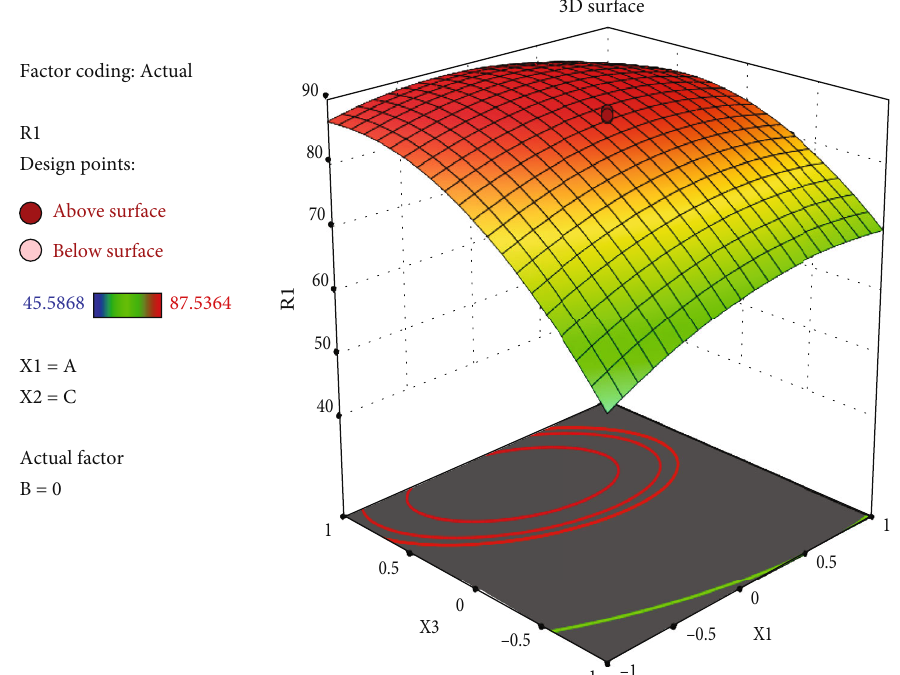
) and time ( X ) on glucose yield ( R 1 2 3D surface